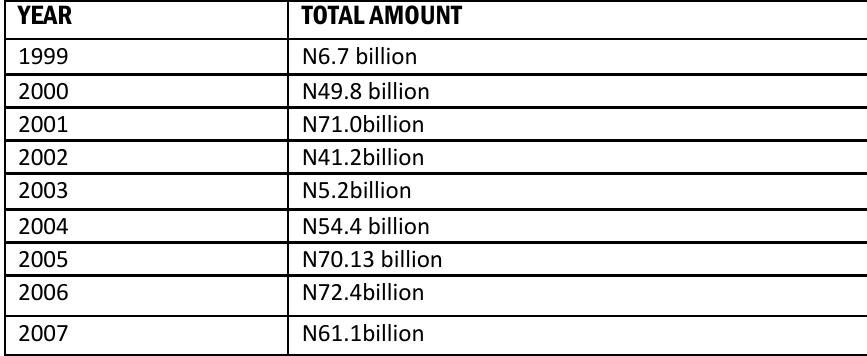
Table 3: Detailed Expenditure on Power Sector (1999